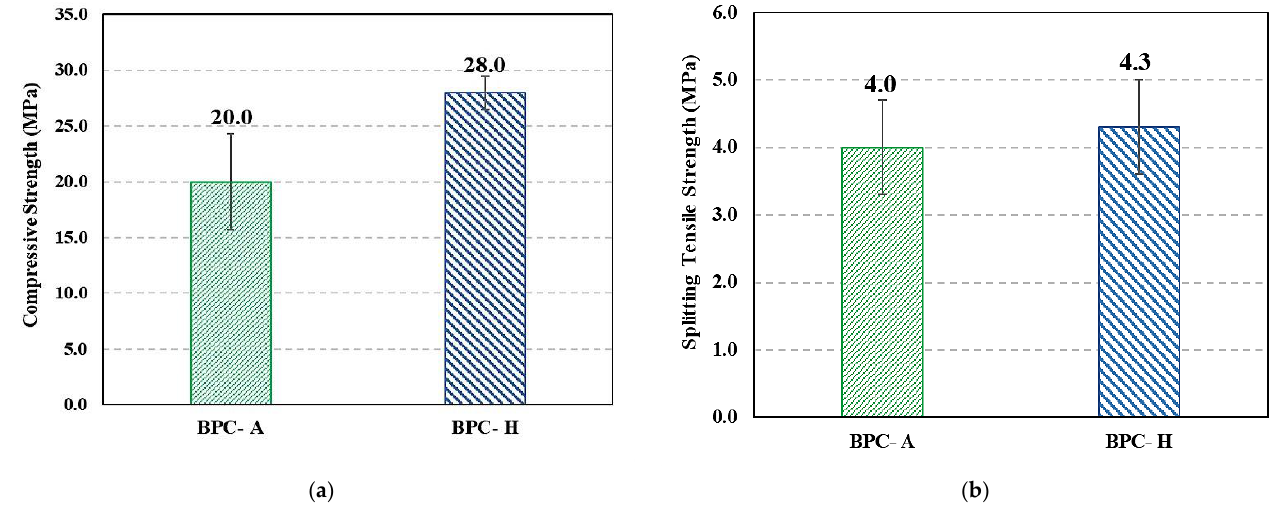
Figure 5. Mechanical strength results: ( a ) compressive strength, and ( b ) splitting tensile strength. Values shown on top of the bar graph represent the mean value.